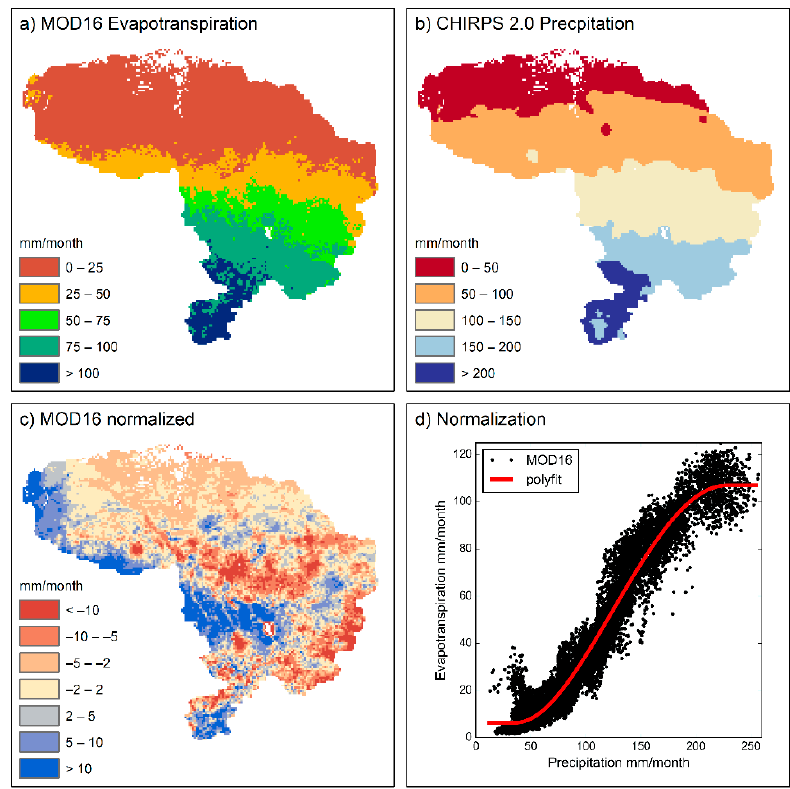
Figure 3. Panel ( a ) depicts the long-term (2002–2011) average monthly rainy-season (June–November) evapotranspiration based on MOD16A2.006. Panel ( b ) shows the long-term average monthly rainy-season (June–November) precipitation based on CHIPRS 2.0. Panel ( c ) presents the precipitation normalized rainy-season evapotranspiration. The fitted polynomial model applied for the normalization is shown in panel ( d ).